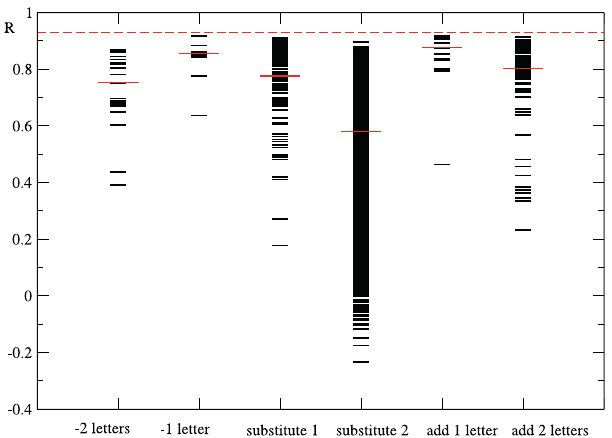
Figure 2. Distribution of the Correlation Coefficient R between OGT and Fractions of Amino Acids in a Proteome for Different Variation of the IVYWREL Set, Additions or Deletions of One or Two Amino Acids to/from the Set, or Substitution of One or Two Amino Acids from the Set by One or Two Amino Acids Not from the Set The dashed red line at R ¼ 0.93 corresponds to the unperturbed IVYWREL. The horizontal red lines indicate the median values of the correlation coefficient for the given type of change of the predictor set.